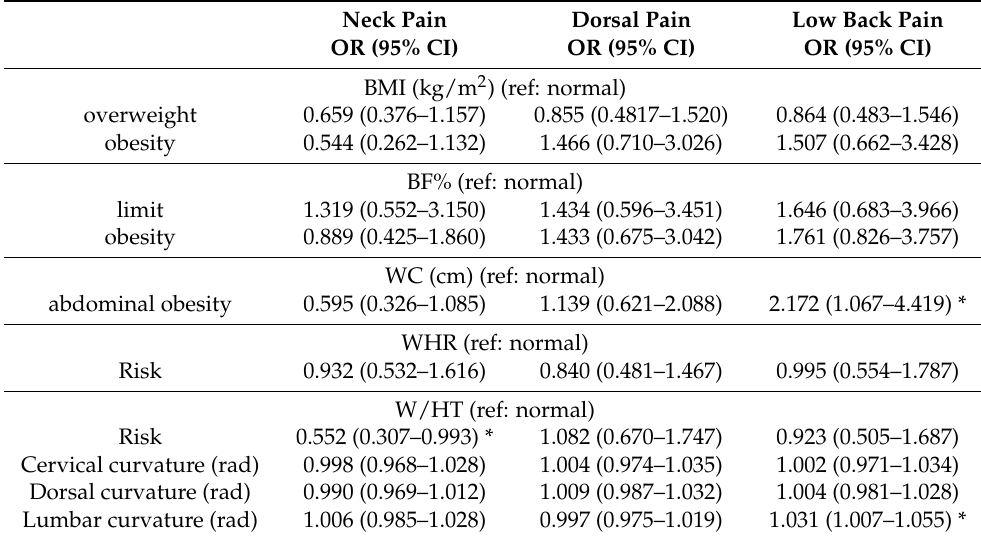
Table 3. Logistic regression models for the evaluation of predictive variables of cervical, dorsal, and lumbar